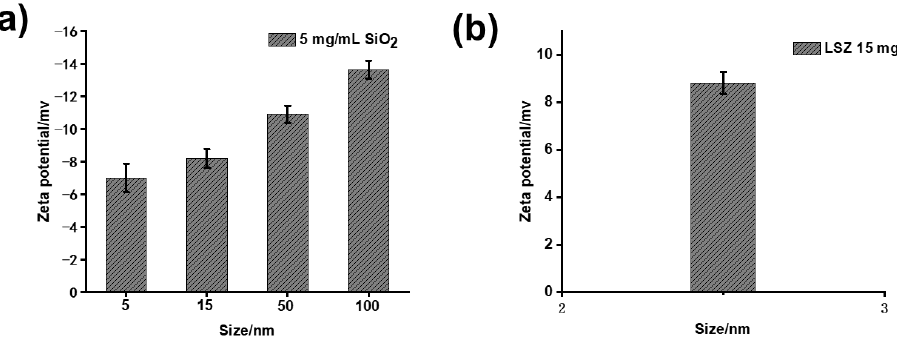
Figure 4. ( a ) Zeta potential of SNP with different particle sizes. ( b ) Zeta potential of lysozyme.